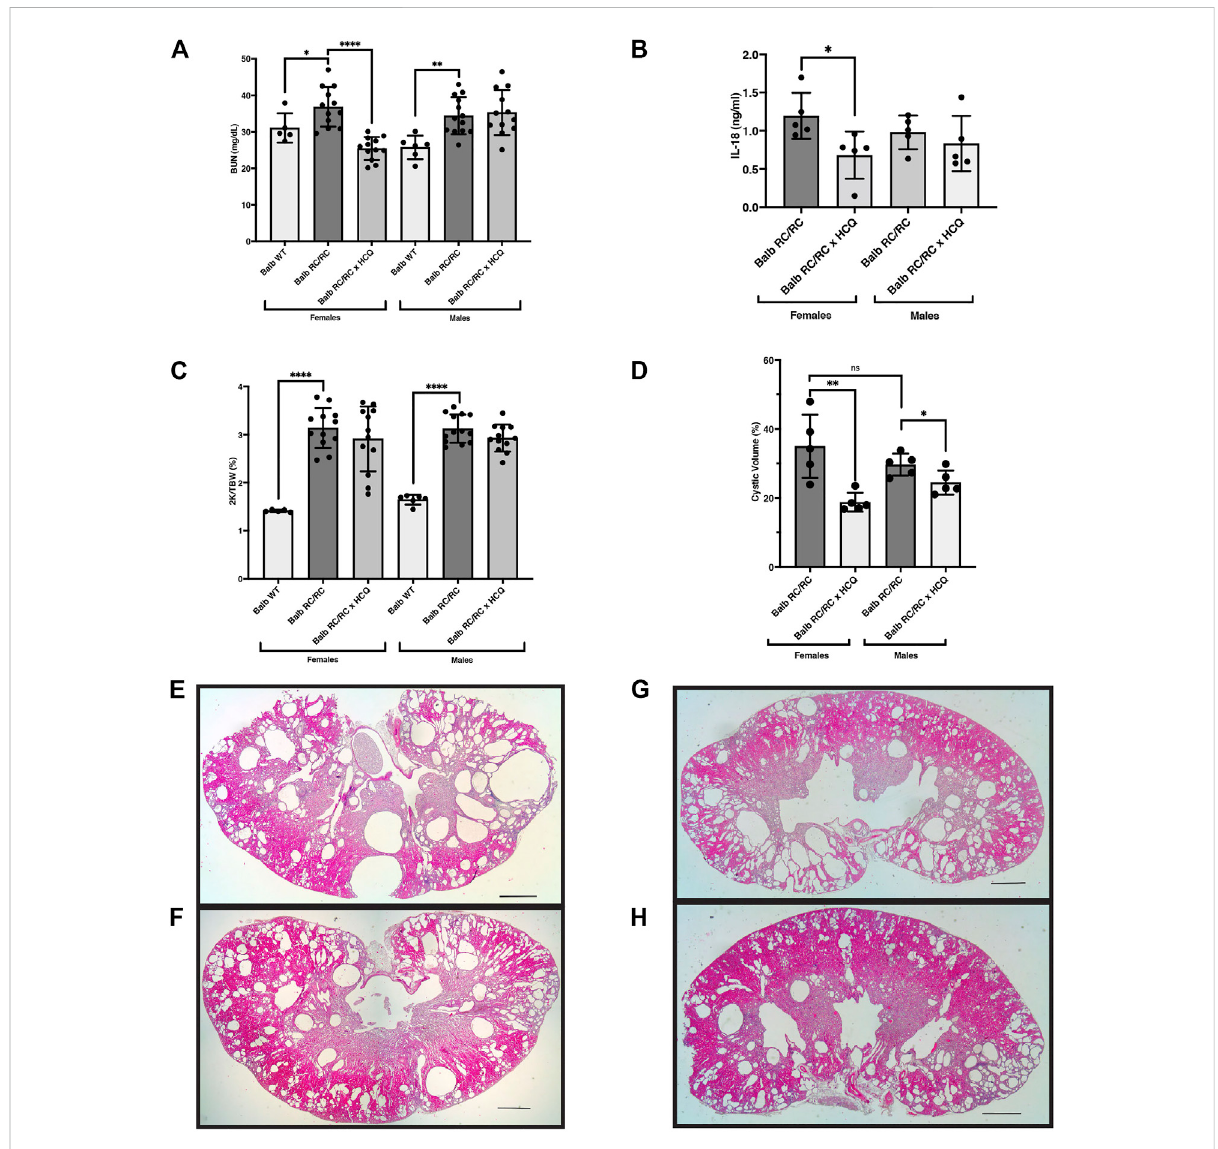
Hydroxychloroquine treatment of RC/RC mice protects kidney function in females and restrains cyst growth in females and males. Shown are measured parameters of PKD progression and serum from RC/RC mice on the BALB/c background that were treated with hydroxychloroquine, and controluntreatedmiceofthesameage. (A) Bloodureanitrogen(BUN)wasdeterminedforeachmouseandplottedforfemalesandmales. (B) Serum IL-18 was measured for the fi ve mice with BUNs closest to the mean for each RC/RC sample type and plotted for females and males. (C) The two-kidney/totalbodyweightpercentage(2K/TBW%)wasdeterminedforeachmouseandplottedforfemalesandmales. (D) Thecysticvolumeasa percentage of total kidney volume was determined for the fi ve mice with BUNs closest to the mean for each RC/RC sample type and plotted for females and males. (E,F) Formalin- fi xed average sized kidneys from HCQ-treated and untreated RC/RC mice were sectioned and stained with hematoxylin and eosin. (E) Untreated female. (F) HCQ-treated female. (G) Untreated male. (H) HCQ-treated male. Scale bars = 1